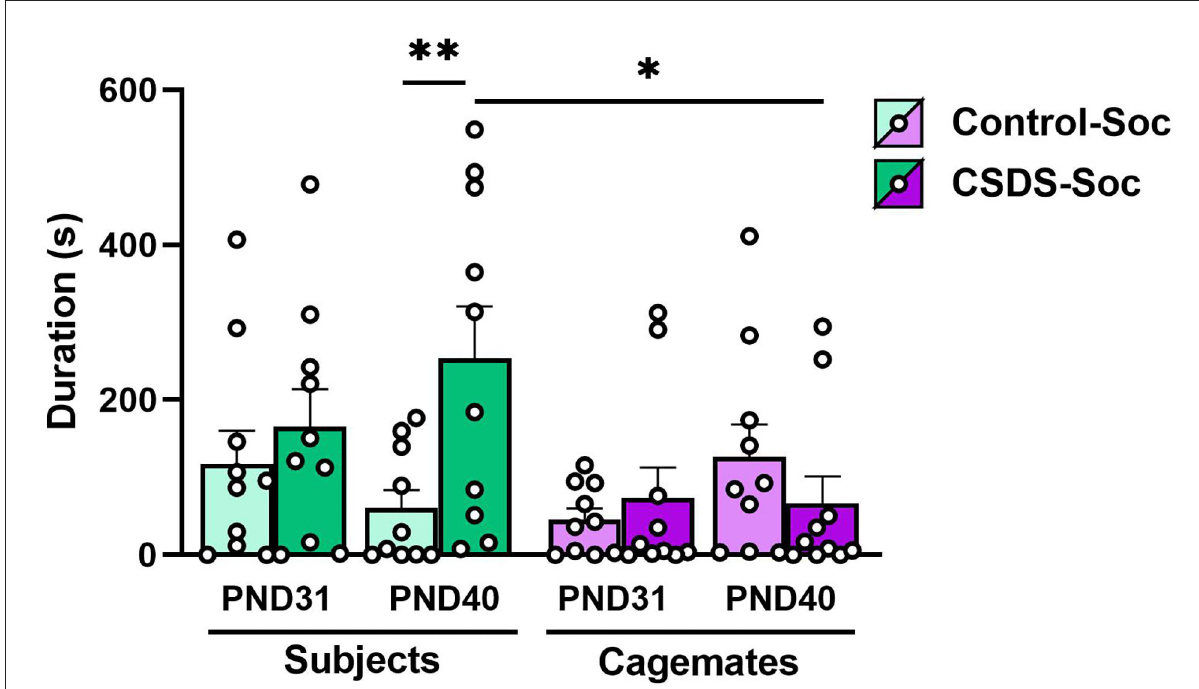
FIGURE3 Effects of acute and chronic social defeat stress on comfort-seeking and consoling behaviors. Duration of comfort-seeking behavior by the Control + Soc (light green bars) or CSDS + Soc (dark green bars) subjects or duration of consoling behavior by the subjects’ corresponding cage-mates (light purple bars for Control + Soc; dark purple bars for CSDS + Soc) after the first social defeat session (PND31) and last social defeat session (PND40). Data are presented as mean ± SEM and dots represent individual data. * p < 0.05; ** p < 0.01.